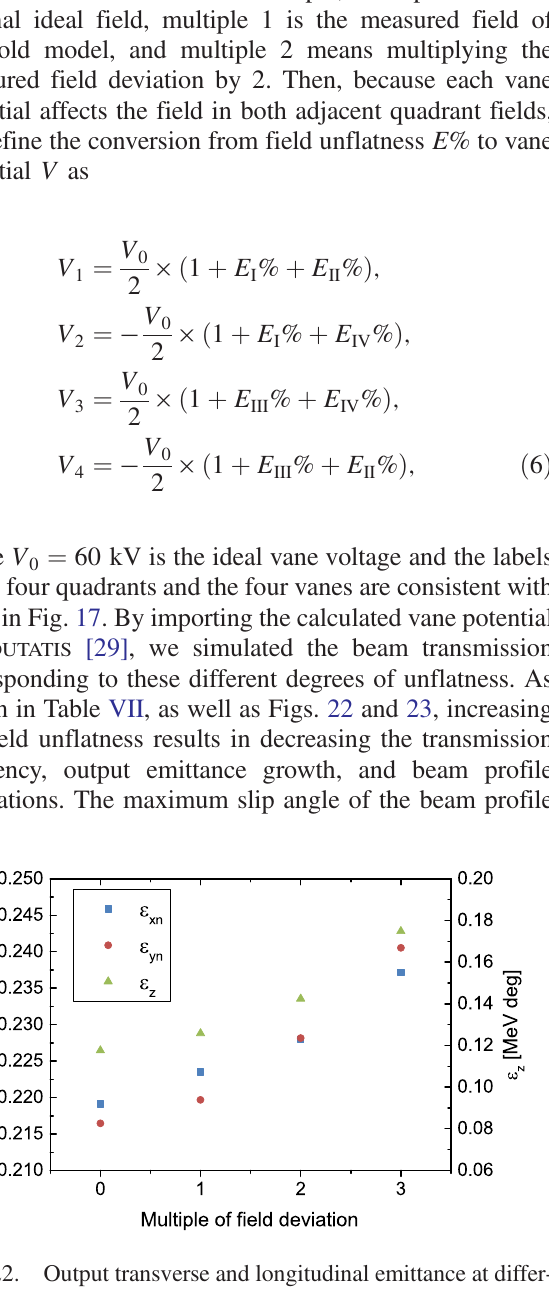
FIG. 21. The left-hand side shows the coupling effect between the quadrants, and the right-hand side shows the magnetic field of the normal four-vane RFQ at the cavity end.